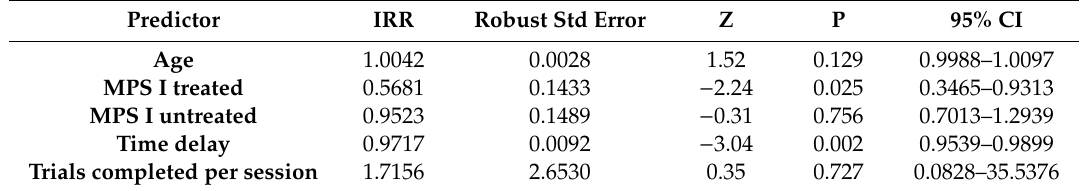
Table 10. Post DNMP mixed e ff ects Poisson regression model. Analysis of MPS I a ff ected groups compared to normal group for choice (correct versus incorrect) at each session x trial, age, time delay, and trials completed.